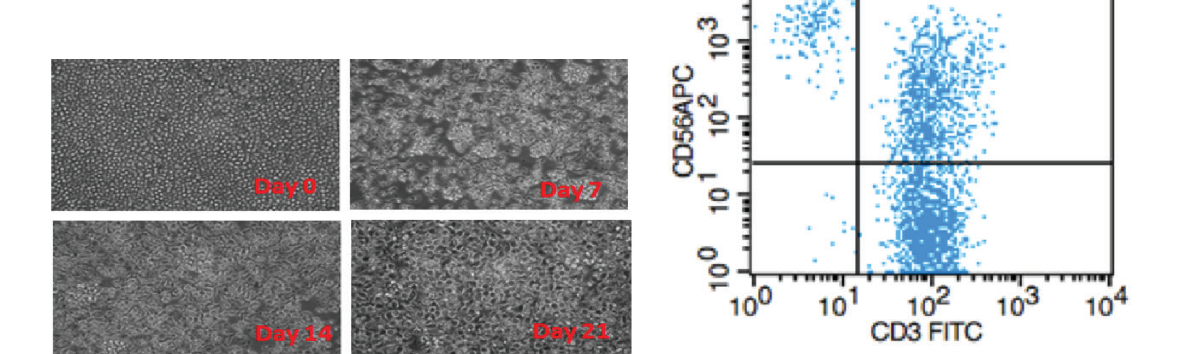
Figure 1: Representative image of CIK cell morphology at days 0, 7, 14 and 21 of culture (magnification, ×100).